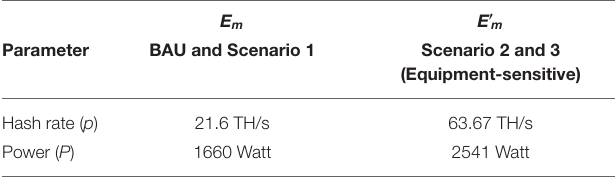
TABLE 2 | Parameters used to model the energy consumption E m and E ′ m of the mining equipment in the different scenarios. E m E ′